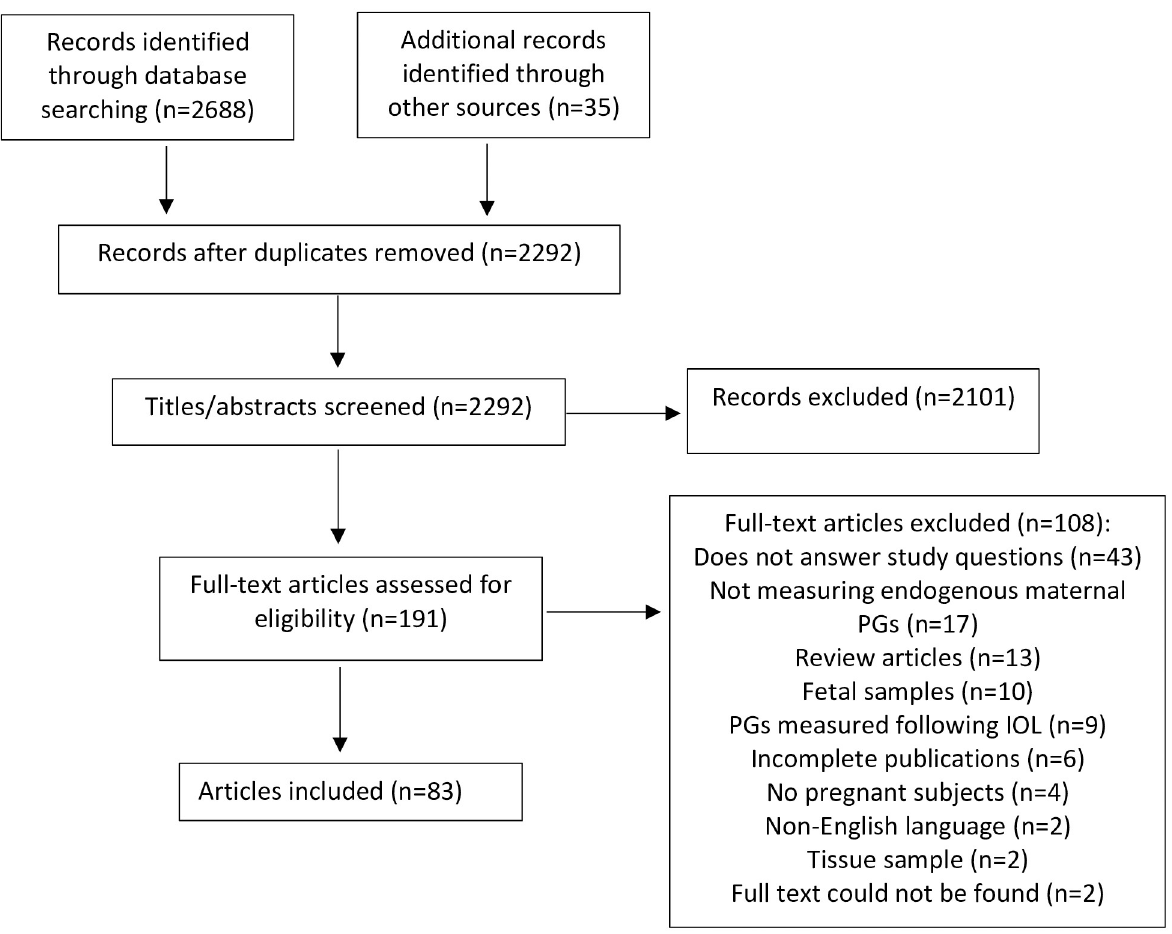
Fig 1. PRISMA diagram. Abbreviations: PG = prostaglandin, IOL = induction of labour.